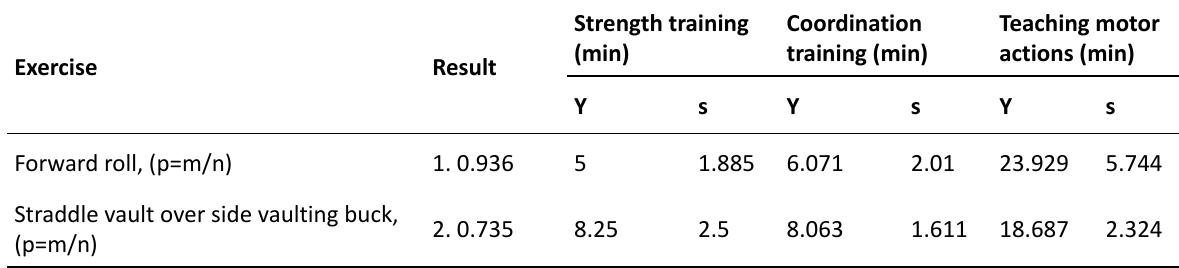
Table 7. Ratio between the means of strength and coordination training according to the indicators of teaching movements to boys aged 8-9 years